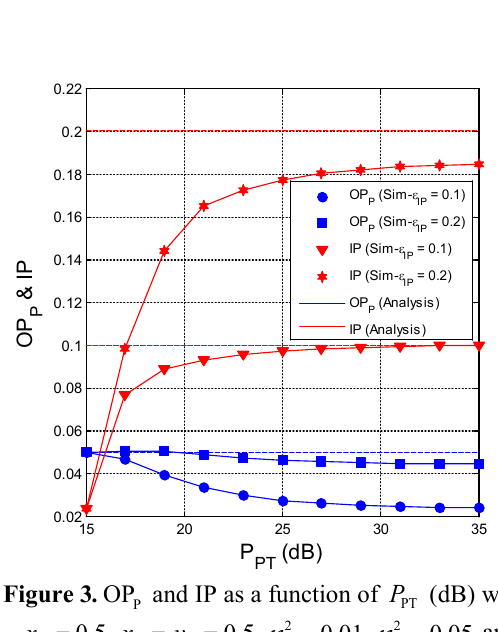
OP and IP as a function of P